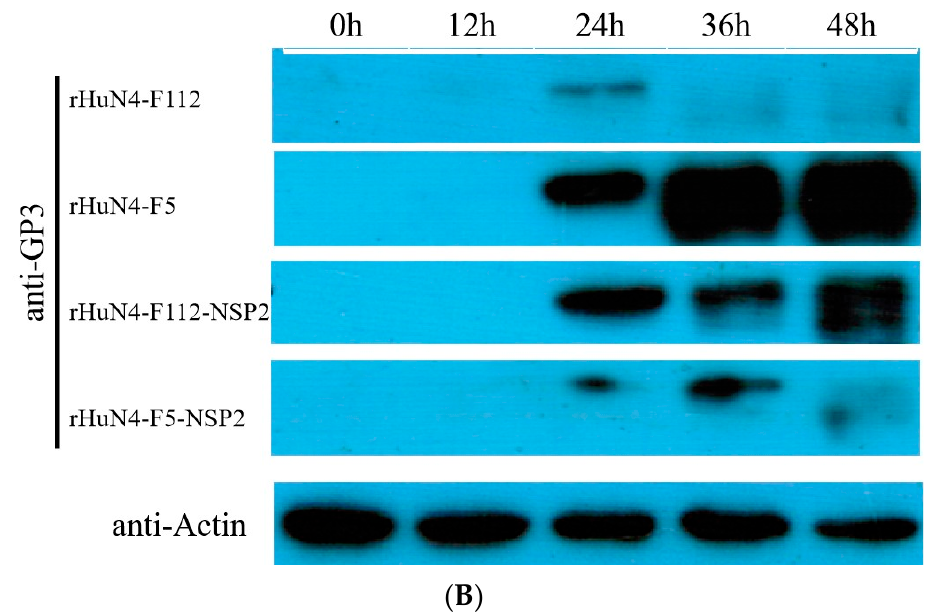
Figure 3. Virus replication on PAMs. ( A ): Viral copies of the chimeric viruses. ( B ): GP3 protein expression after infection. * p < 0.5, ** p < 0.01.